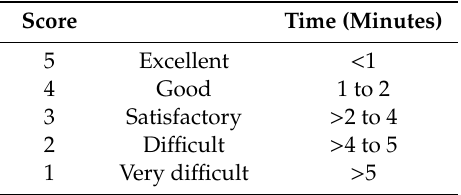
Table 1. Scoring system for ease of access to the coelom, modified from Divers et al.,